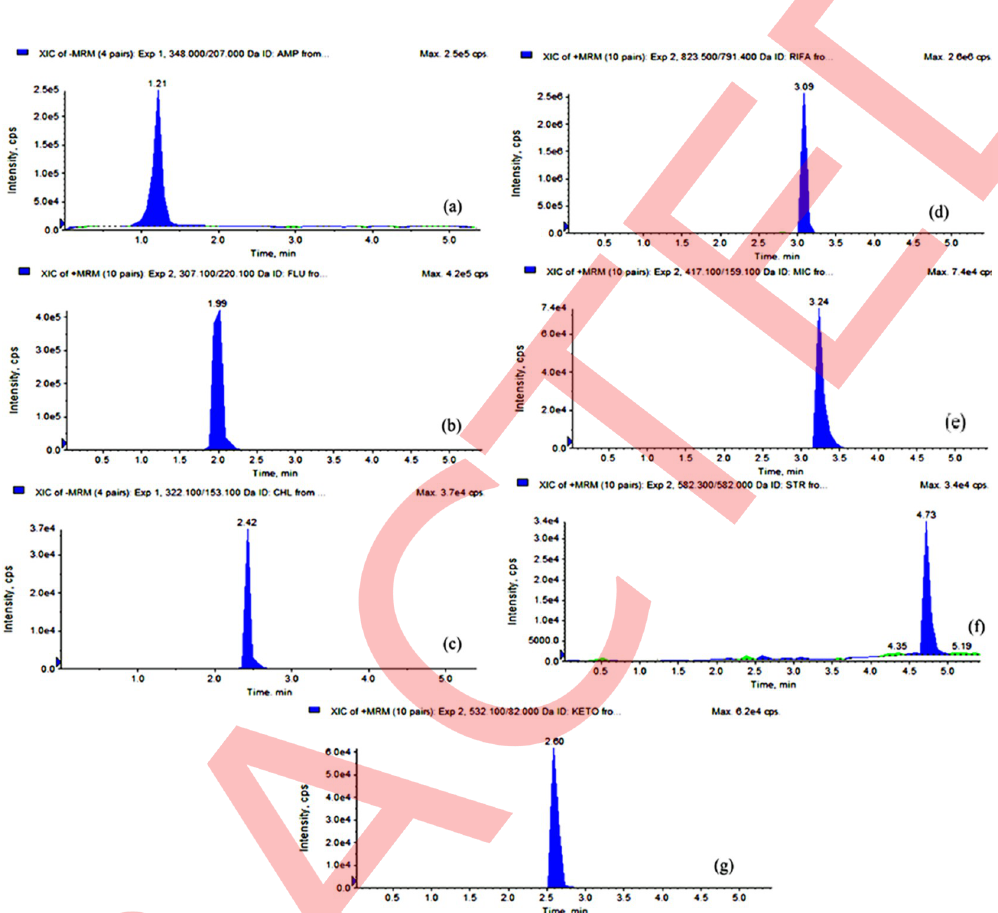
Fig 9. MRM extracted ion chromatogram of reference analytes: (a) Ampicillin; (b) Fluconazole; (c) Chloramphenicol; (d) Rifampicin; (e) Miconazole; (f) Streptomycin and (g) Ketoconazole .